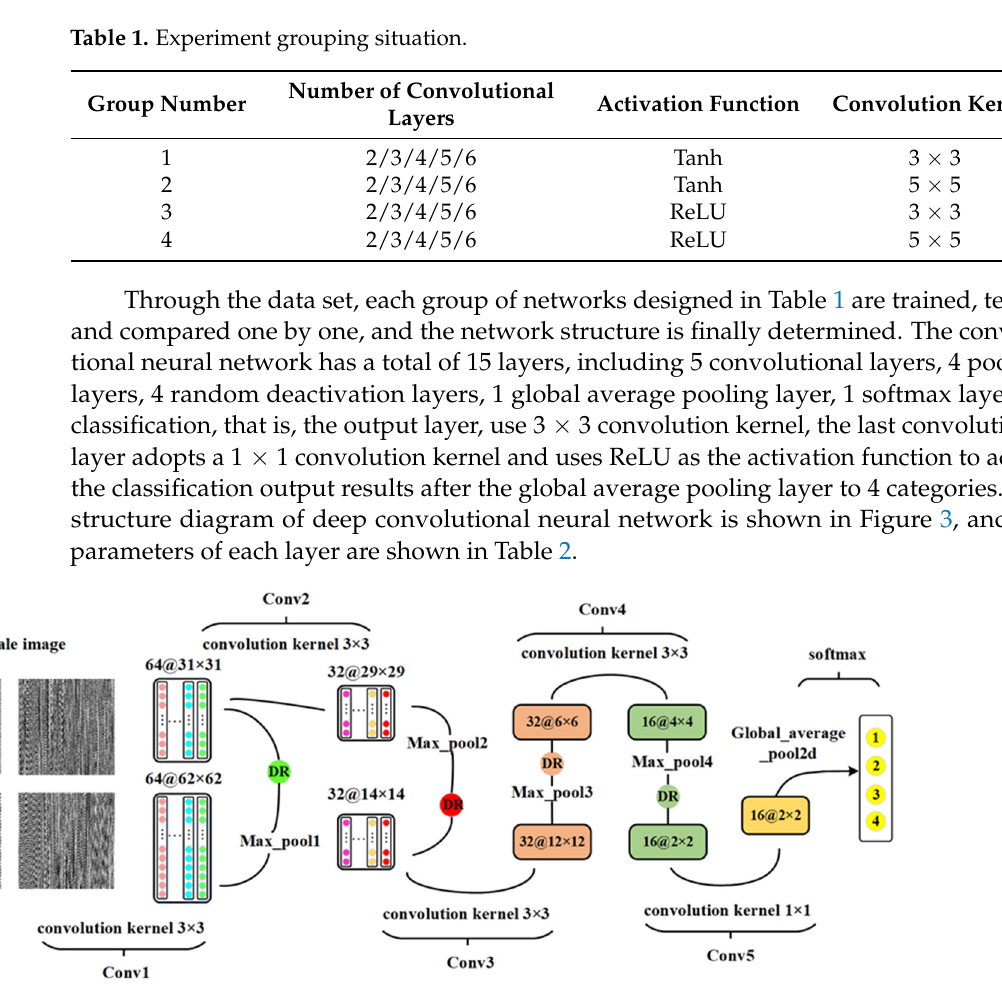
Figure 3. Deep convolutional neural network structure diagram. Table 2. The structure and parameters of the DCNN networks.